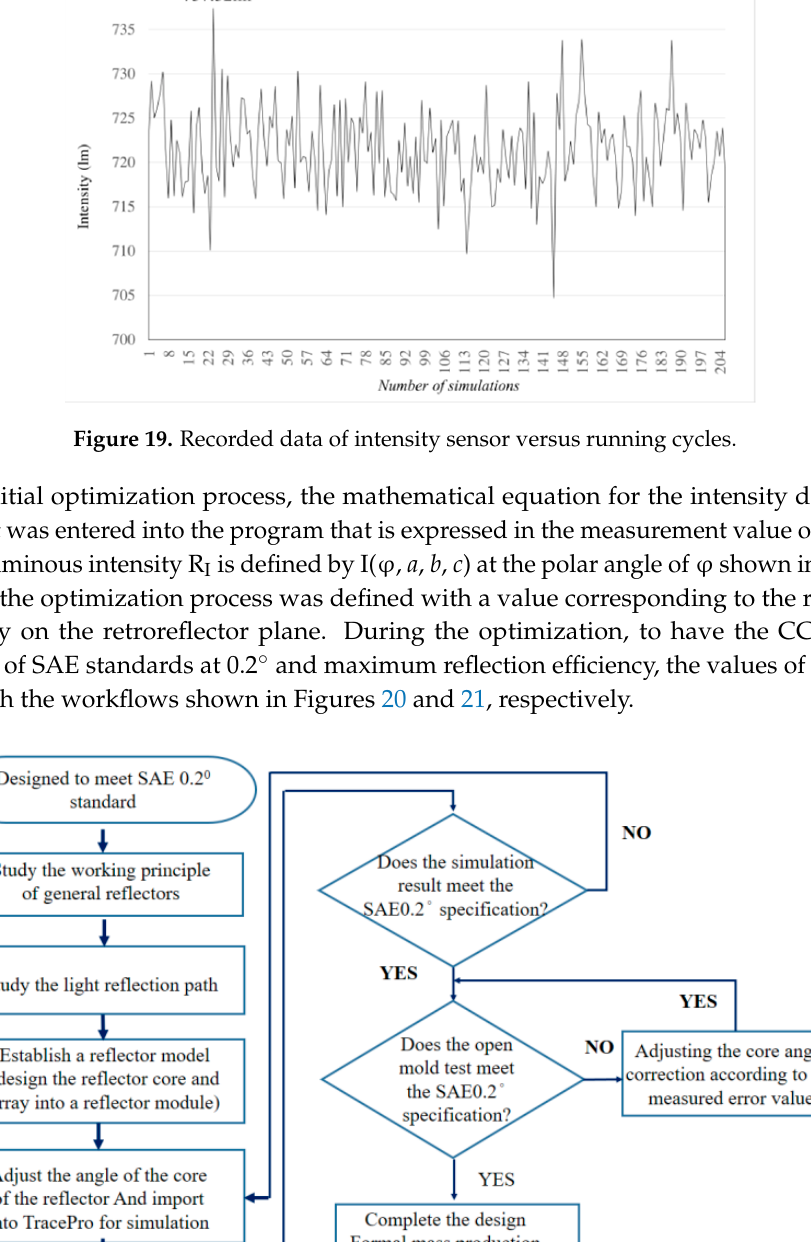
Figure 18. Height difference d i between neighboring pins in a double-pin group. The object function f defined by Equation (4) was determined in the optimization process. The optimization process encompassed three fragments. Object function: The equation that describes the value of the object function of the optimization program established by the genetic algorithm is as follows: 𝑓(cid:4666)𝑖, 𝑗(cid:4667) = ∑ (cid:3493)𝑤 (cid:3036) (cid:4666)𝑚 (cid:3036) − 𝑡 (cid:3036) (cid:4667) (cid:2870) + 𝑤 (cid:3037) (cid:4666)𝑚 (cid:3037) − 𝑡 (cid:3037) (cid:4667) (cid:2870)(cid:3041) (cid:3036),(cid:3037)(cid:2880)(cid:2869)